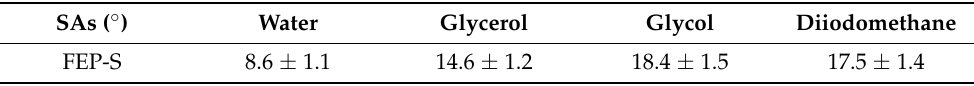
Table 3. SAs for different liquids of FEP-S coatings (proportions of micro/nano-silica is